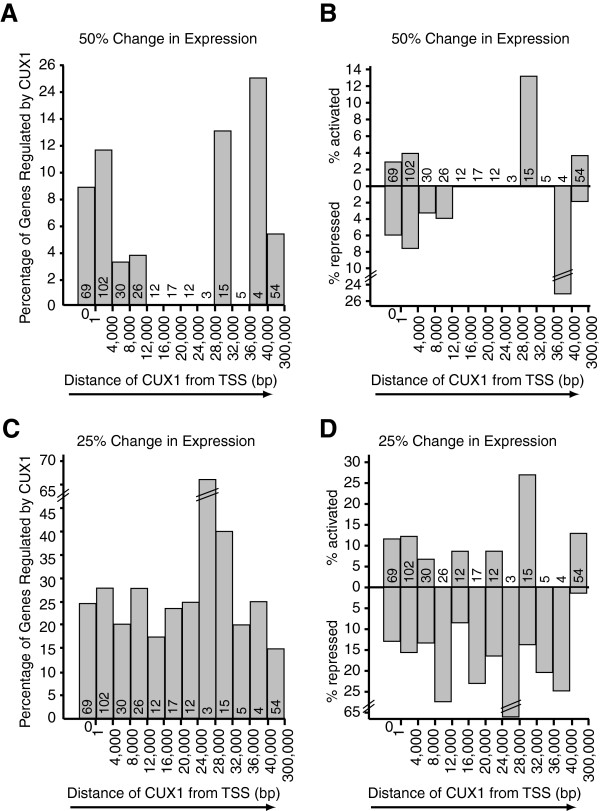
Effect of Distance on Regulation by CUX1. (A) Genes from
the ENCODE array have been organized according to the distance between
their transcription start site (TSS) and the closest CUX1 binding site.
The "0" column indicates genes where the CUX1 binding site overlaps the
start site. The histogram shows, for each interval of distance, the
percentage of genes that exhibit a 1.5 fold change in expression
following p110 CUX1 overexpression or CUX1 knockdown. The total number
of genes within each interval is indicated within each column.
(B) As in A, except that the regulation by CUX1 is
expressed as either activation by CUX1 or repression by CUX1. (C)
As in A, but with a threshold of 1.25 fold change in expression.
(D) As in B, but with a threshold of 1.25 fold change
in expression.